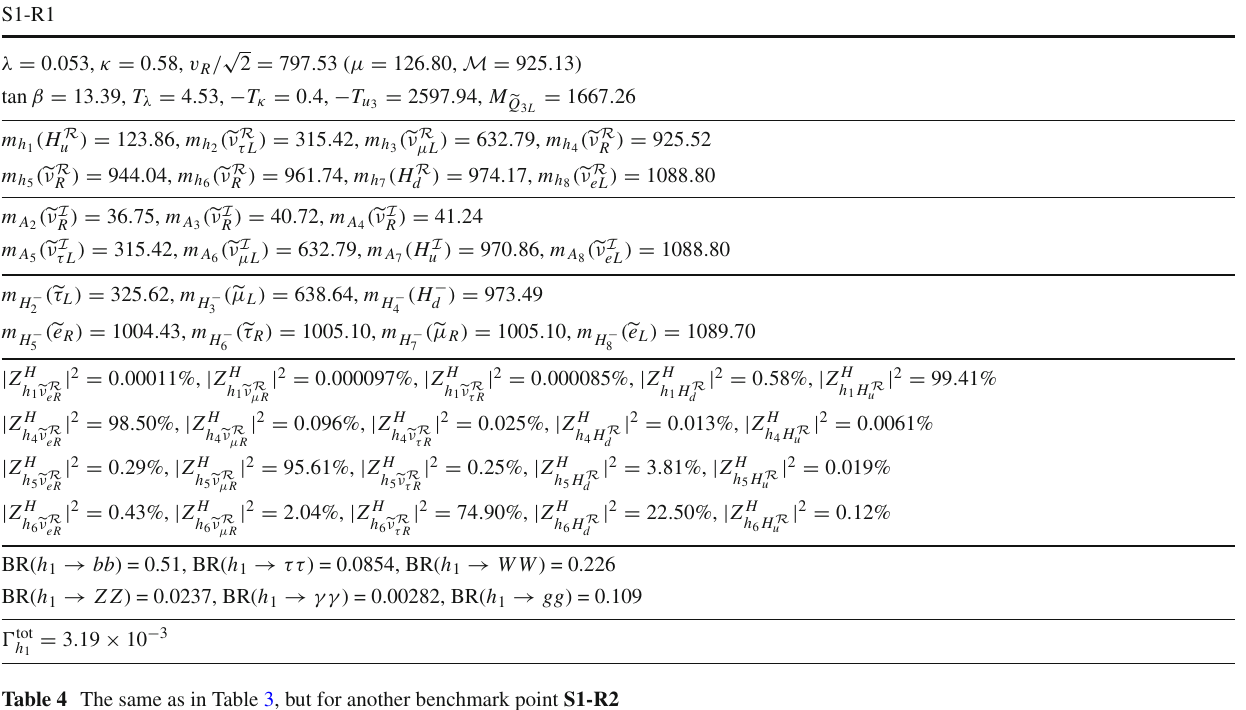
Table 4 The same as in Table 3, but for another benchmark point S1-R2